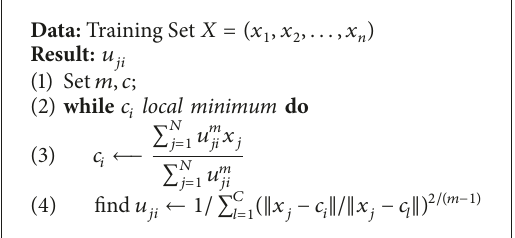
Algorithm 2: FCM algorithm in the stroke dataset and 2D mBd stroke datasets.